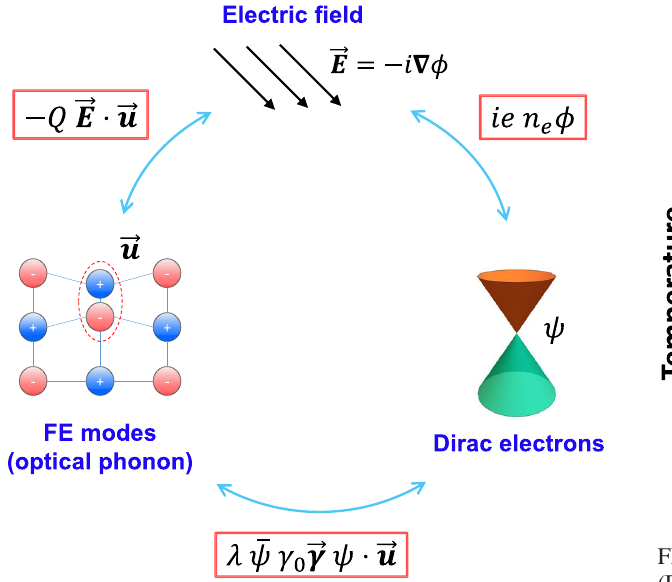
down.FIG. 2. The three fields participating in the low-energy effective field theory Eq. (8) and the couplings between them. The fields are the ferroelectric fluctuations (optical phonon distortions), Dirac electrons, and static electric field. The coupling of the ferroelectric mode to the electric field leads to the gapping out of the longitudinal optical mode (LO-TO splitting) and to the well- known Fröhlich coupling; see Eq. (12). The coupling of the electrons to the electric field generates the Coulomb repulsion. An important new element, which is one of the key points of the paper, is the direct coupling λ between the optical